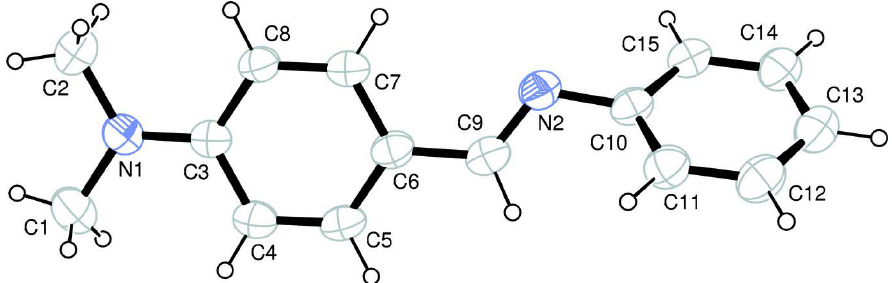
Figure 1 The molecular structure of (I), with displacement ellipsoids drawn at the 30% probability